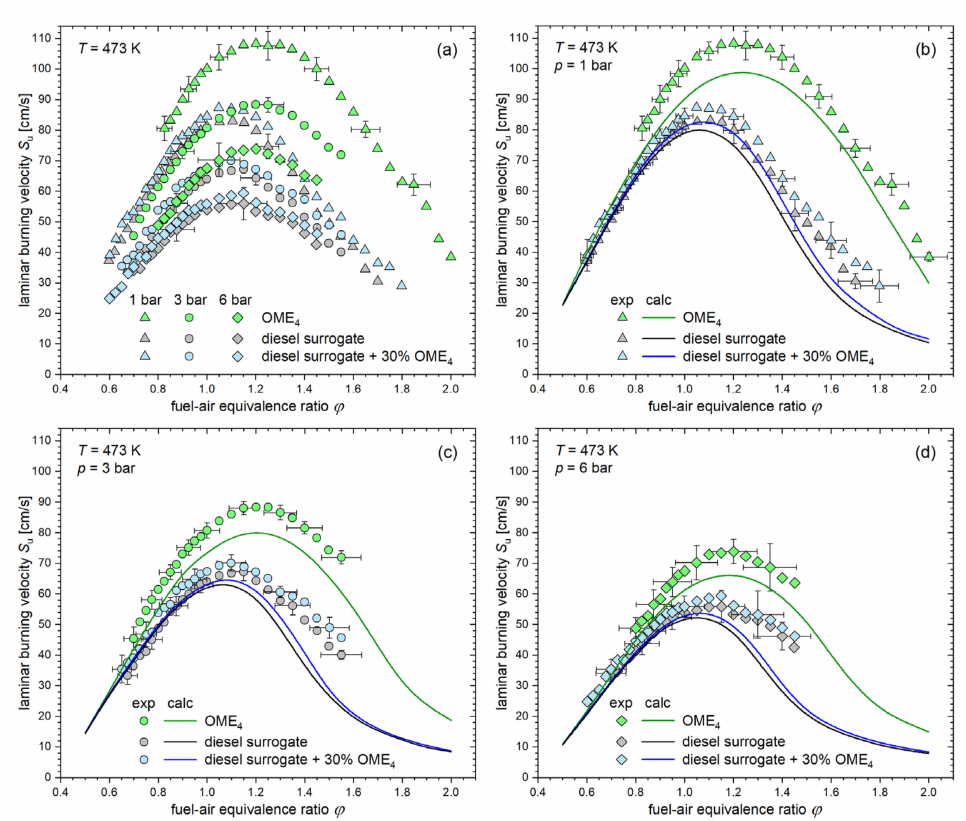
Figure 8. Results of the measured laminar burning velocities at T = 473 K of the diesel surrogate, neat OME 4 , and diesel surrogate and 30% ( w / w ) OME 4 ( a ) and comparison between the experimental data and the calculated laminar flame speeds for 1 bar ( b ), 3 bar ( c ), and 6 bar ( d